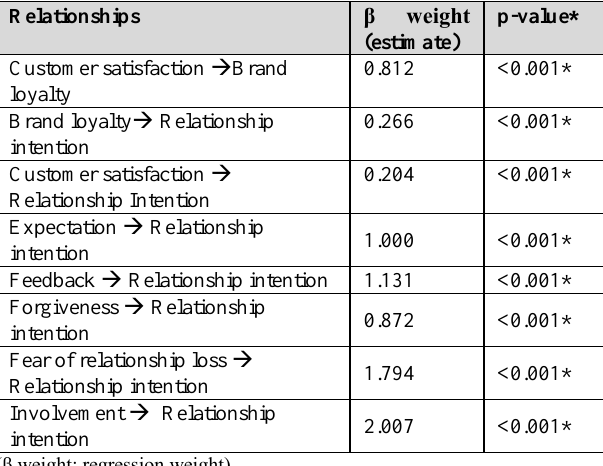
Table 3: Regression weights of the structural model Relationships